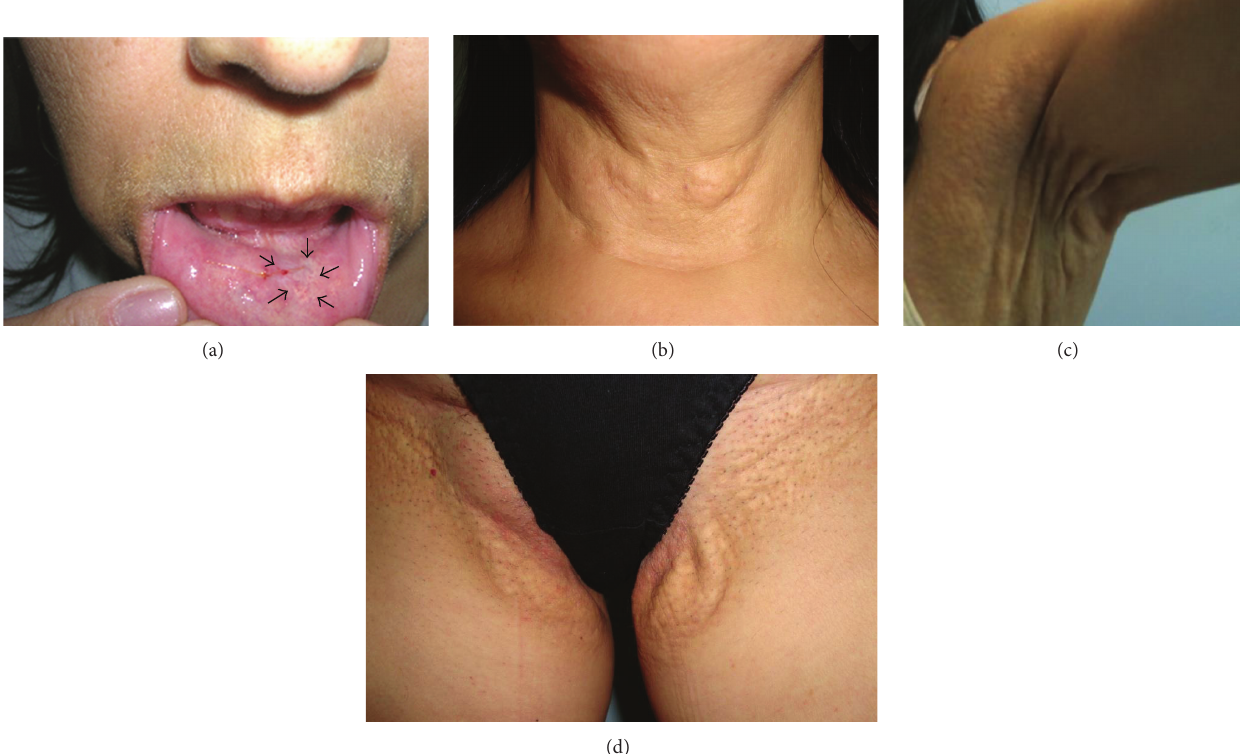
Figure 1: Clinical signs of the lesions. (a) White macule on the lower lip (arrows). (b) Skin lesion in the neck. (c) Skin lesion in the axillary region. (d) Skin lesion in the inguinal